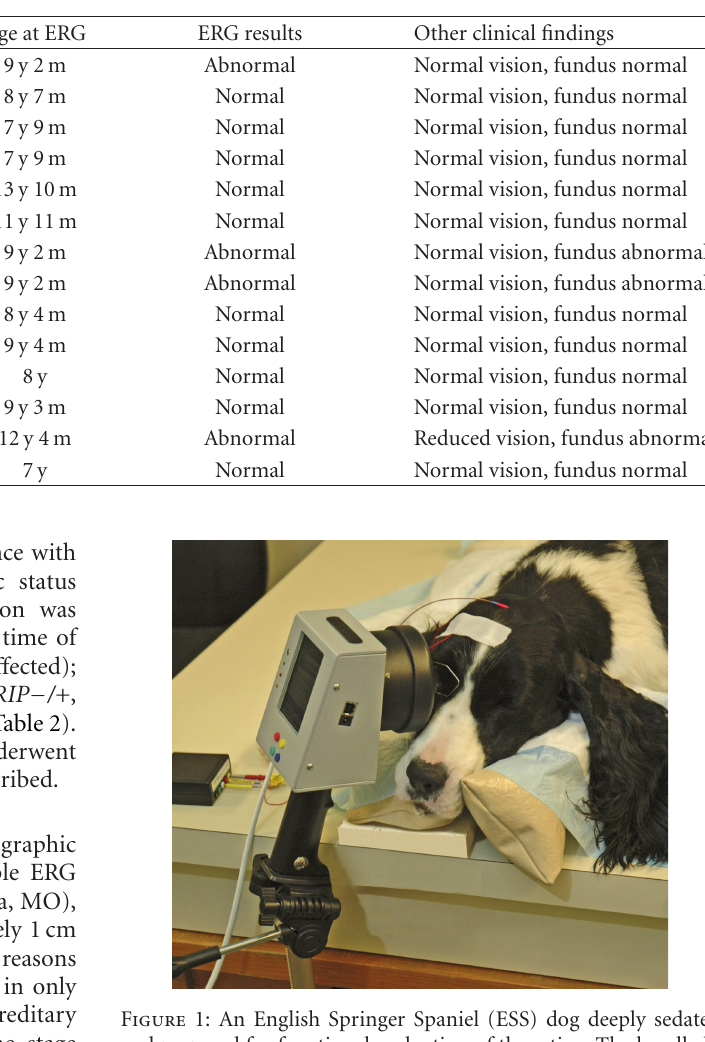
Table 2: Details in regards to dogs in the masked ERG study. The genotypes are given as − / − for genetically a ff ected, +/ − for carriers, and +/+ for genetically clear individuals of the 44 bp deletion in exon 2 of the RPGRIP1 gene. The age at the time for ophthalmic and ERG examinations is given as years (y) and months (m).